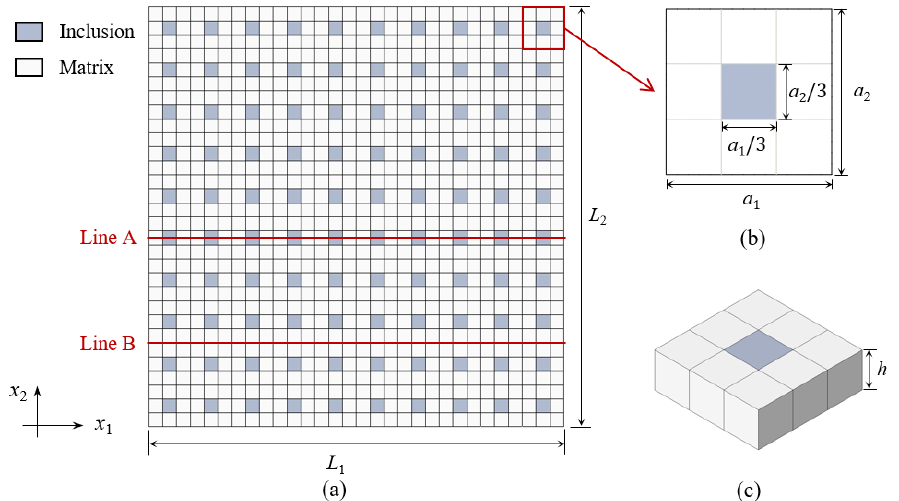
Figure 8. Single-layer periodic plate and its unit cell. ( a ) 2D periodic plate with single inclusion; ( b ) 2D unit cell; ( c ) 3D representative unit cell.